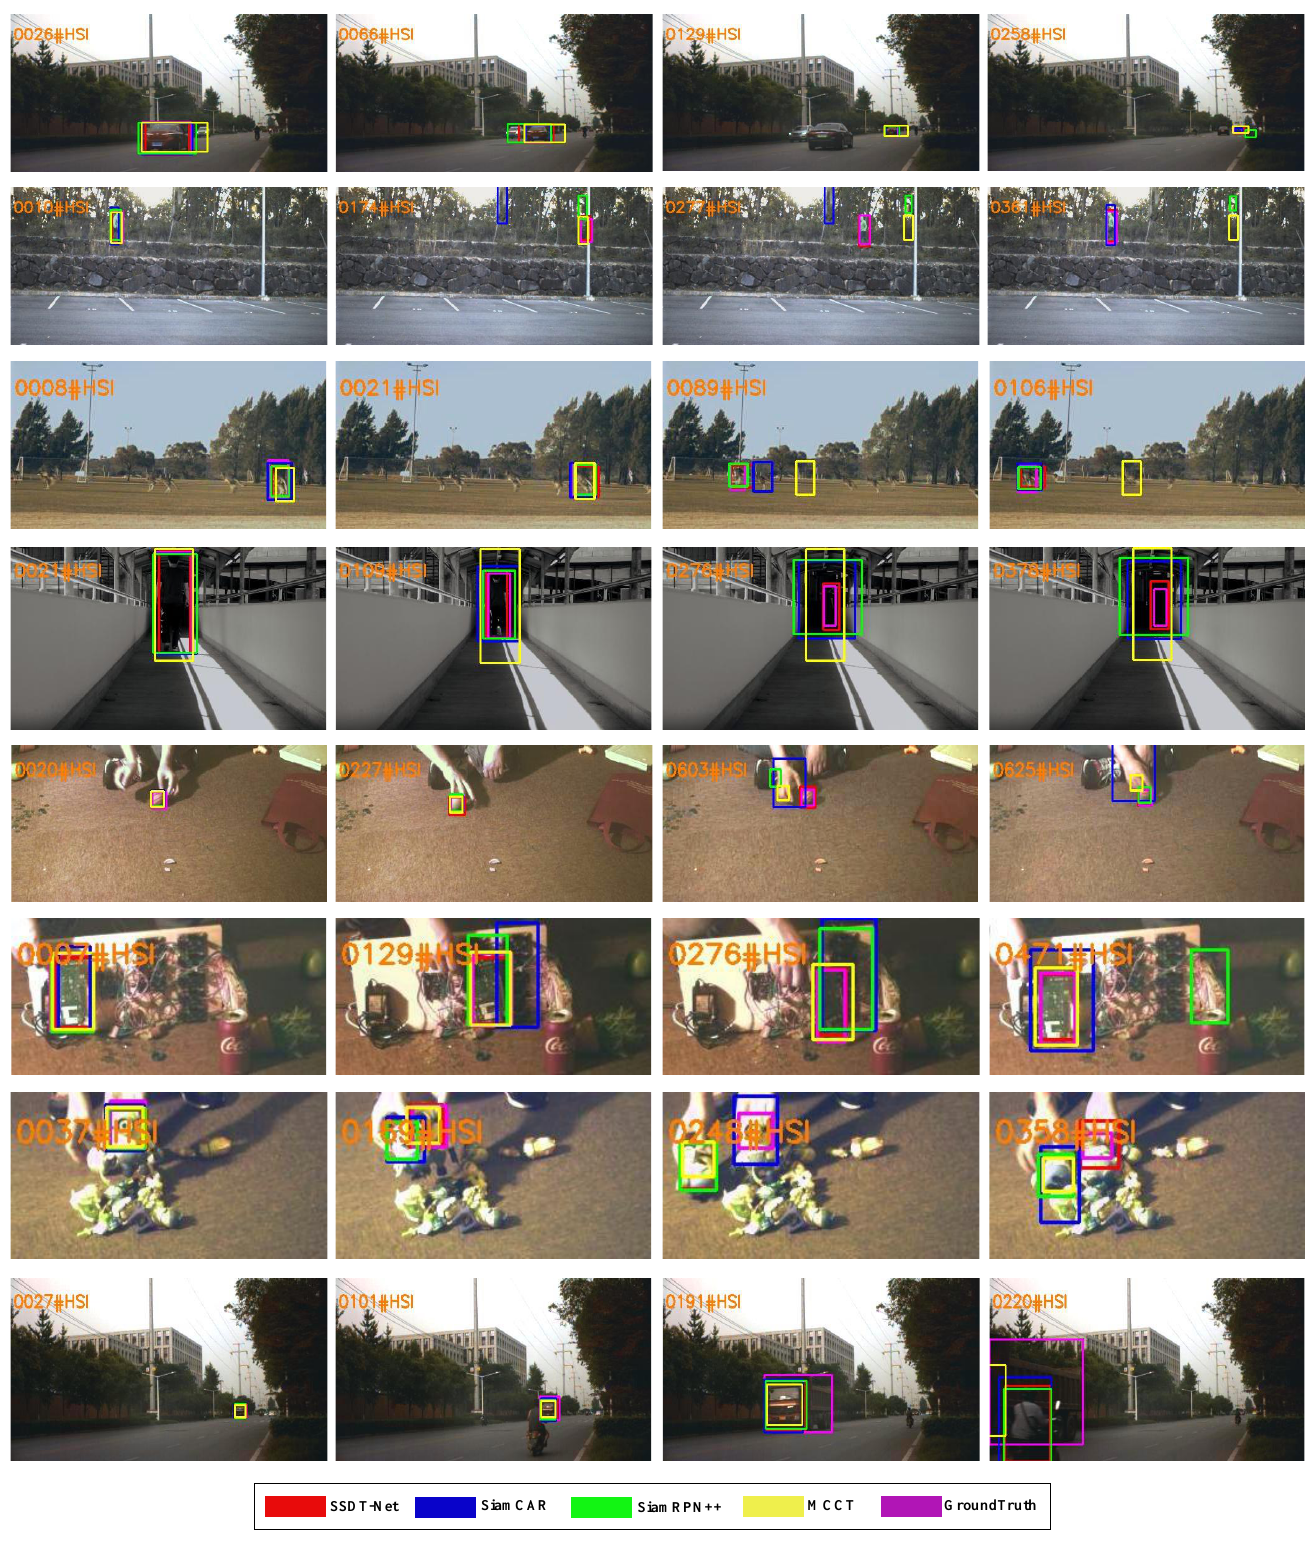
Figure 9. Visualization results of our proposed hyperspectral tracker and several color trackers (scenes: car3, forest2, kangaroo, student, ball, board, toy1, and